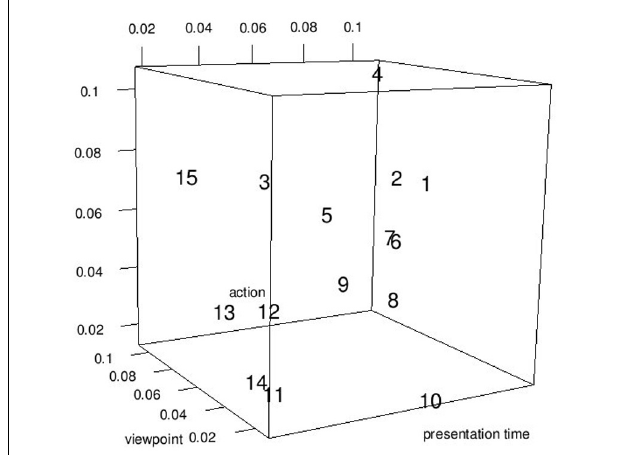
FIGURE 8 | Relative importance of each predictor (numbers) of Table 1 shown for each experimental factor separately. The numbers refer to the predictor number in Table 1